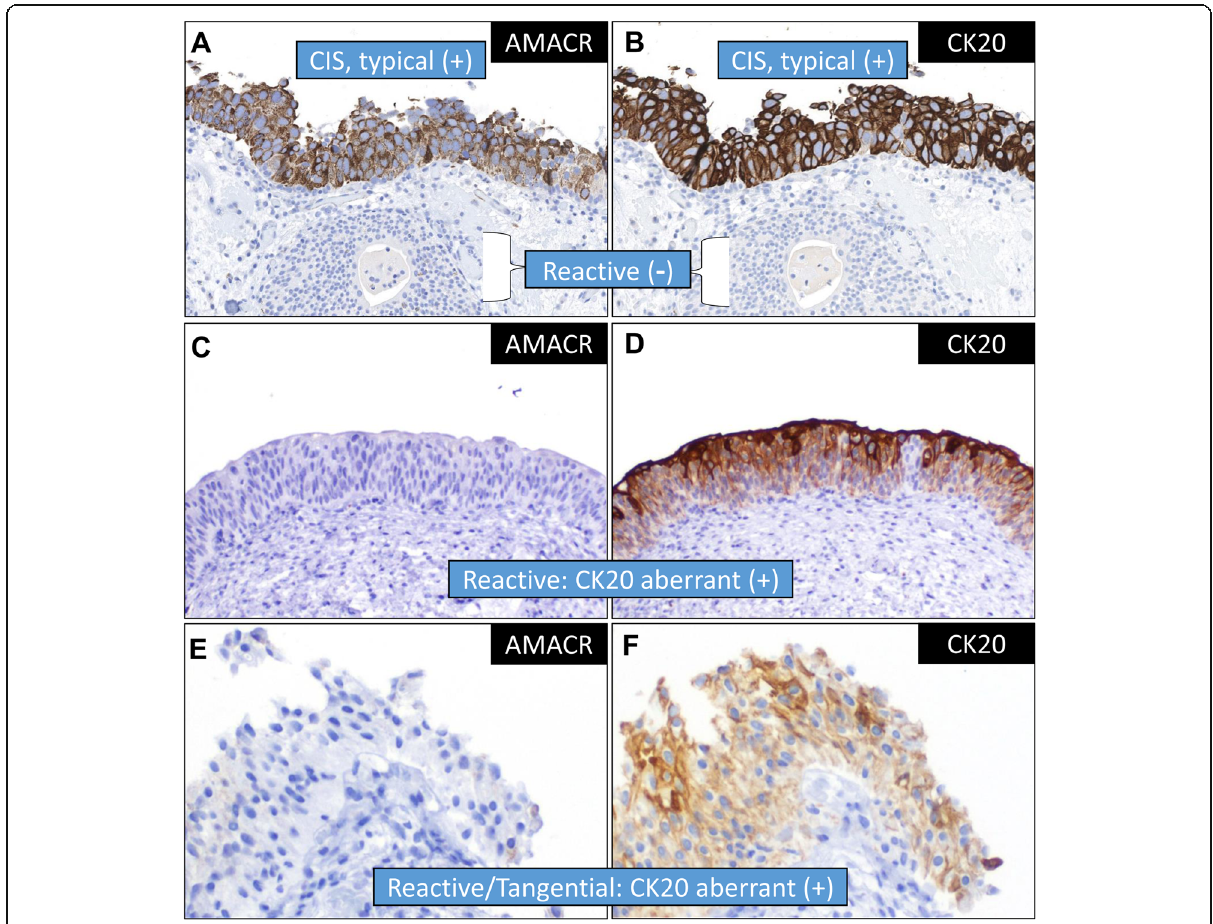
Fig. 1 The most characteristic pattern of staining in urothelial carcinoma in situ (CIS) was of diffuse, full thickness (+) staining for AMACR ( a ) and CK20 ( b ). AMACR typically demonstrated reduced intensity and a granular cytoplasmic pattern, as compared to CK20; additionally, reactive urothelium in the nest of cystitis cystica underlying the surface CIS demonstrates expected negativity for both markers. Two examples of